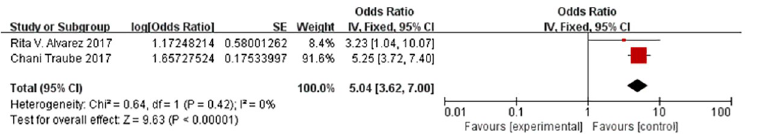
Fig 5. Forest plot for anticholinergic drug use analysis. We conducted meta-analysis for 2 studies using a random effects model. We used ORs and 95% CIs to represent the results.